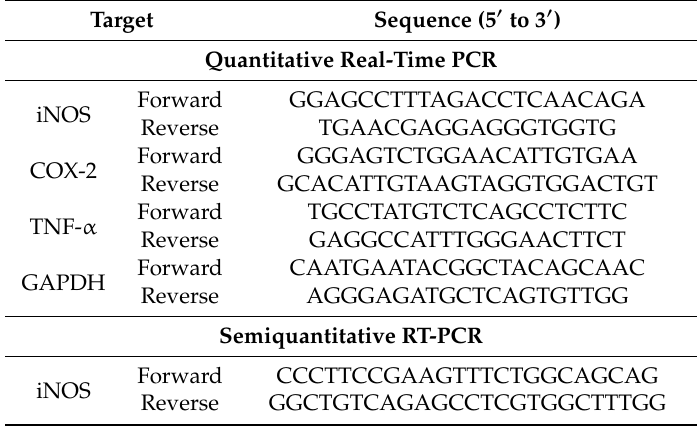
Figure 1. Linusorb mixture (LOMIX) has anti-inflammatory activity in macrophages. ( A ) Chemical structures of LOMIX components. ( B ) RAW264.7 cells pretreated with the indicated doses of LOMIX for 30 min were treated with either LPS (1 µg/mL), Pam3CSK4 (10 µg/mL), or Poly(I:C) (200 µg/mL) for 24 h. The NO level in cell culture media was determined by Griess assay. ( C ) RAW264.7 and HEK293 cells were treated with the indicated doses of LOMIX for 24 h, and the cell viability was determined by MTT assay (left panel). Photos were taken with a digital camera (right panel). ( D ) RAW264.7 cells pretreated with the indicated doses of either ( D left ) L-NAME or ( D middle ) Pred for 30 min were treated with LPS (1 µg/mL) for 24 h, and NO level in the cell culture media was determined by Griess assay. ( D right ) RAW264.7 cells were treated with the indicated doses of either L-NAME or Pred for 24 h, and the cell viability was determined by MTT assay. RAW264.7 cells pretreated with LOMIX (200 µg/mL) for 30 min were treated with LPS (1 µg/mL) for 24 h. ( E left ) Cell shape was photographed, and ( E right ) the number of cells with an altered shape was counted using a hemocytometer and plotted. ## p < 0.01 compared to the vehicle-treated control. * p < 0.05, ** p < 0.01 compared to the stimulator-treated controls. Original magnification of ( E ) was 250×. Table 1. Primer sequences used for polymerase chain reaction (PCR).